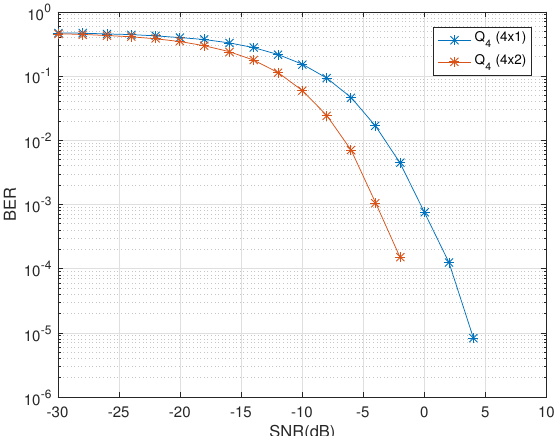
Figure 5. BER Vs SNR performance of Q 4 for (4 × 1) and (4 × 2) antenna